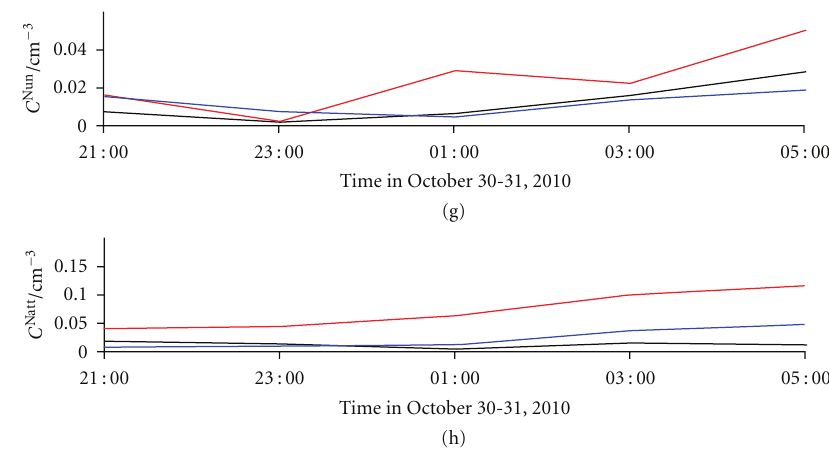
Figure 13: Time run of: (a) total number concentration of general aerosol particles ( C N (tot)) and geometric mean values of their diameters gen ( d GM ), (b) activity concentration of radon ( C A ) and equilibrium equivalent activity concentration of radon decay products ( C A ), (c) Rn RnDP number fraction of particles smaller than 10 nm ( x gen ( < 10)) and smaller than 20 nm ( x gen ( < 20)), (d) activity fraction of the unattached RnDP , C Aun 214 , and ( f un ) and number fraction of the unattached RnDP ( x un ), (e) activity concentrations of the unattached RnDP atoms ( C Aun 218 Pb Po C Aatt C Aatt C Aatt C Aun 214 Bi ), (f) activity concentrations of the attached RnDP atoms ( 218 Po , 214 Pb , and 214 Bi ), (g) number concentrations of the unattached , C Nun 214 , and C Nun 214 ), and (h) number concentrations of the attached RnDP atoms ( C Natt 218 , C Natt 214 , and C Natt 214 ), in RnDP atoms ( C Nun 218 Pb Bi Pb Bi Po Po indoor air for the period October 30-31 (with closing of the window in the kitchen at 23:30 on October 30).